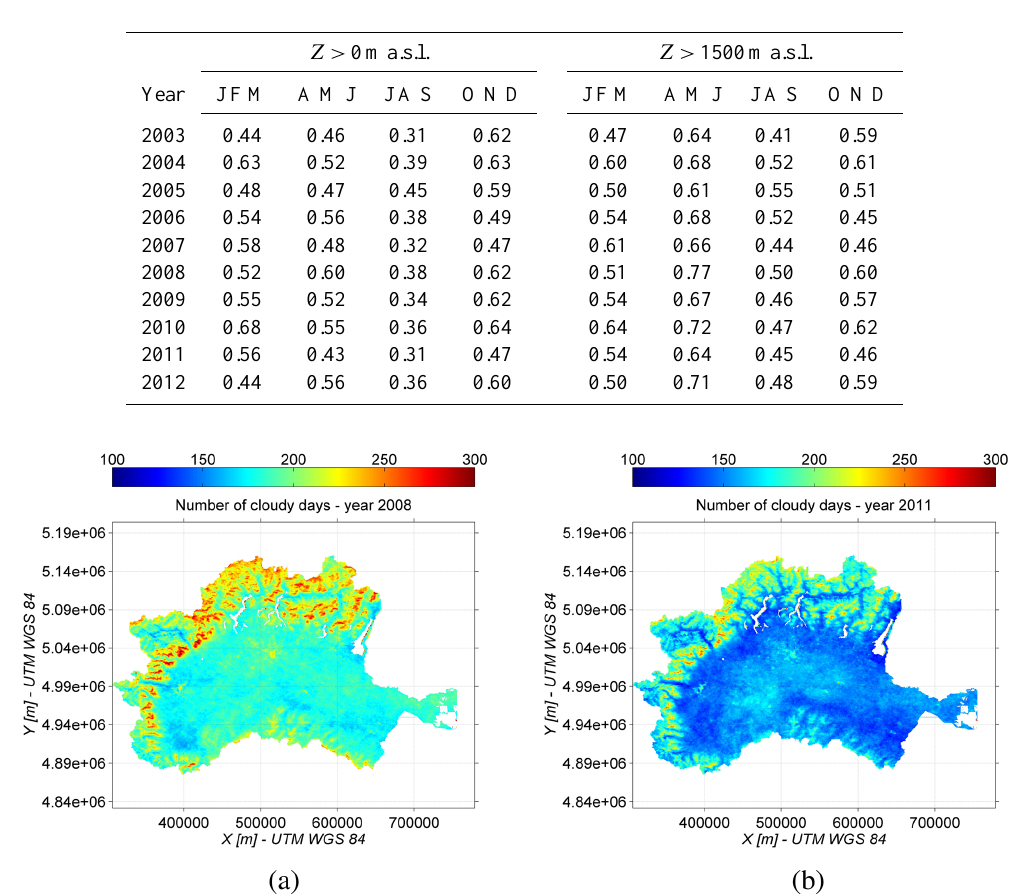
Table 4. Cloud cover fraction over the Po River basin averaged per quarter from MOD10A1. Values refer to the entire basin and to the area higher than 1500ma.s.l.